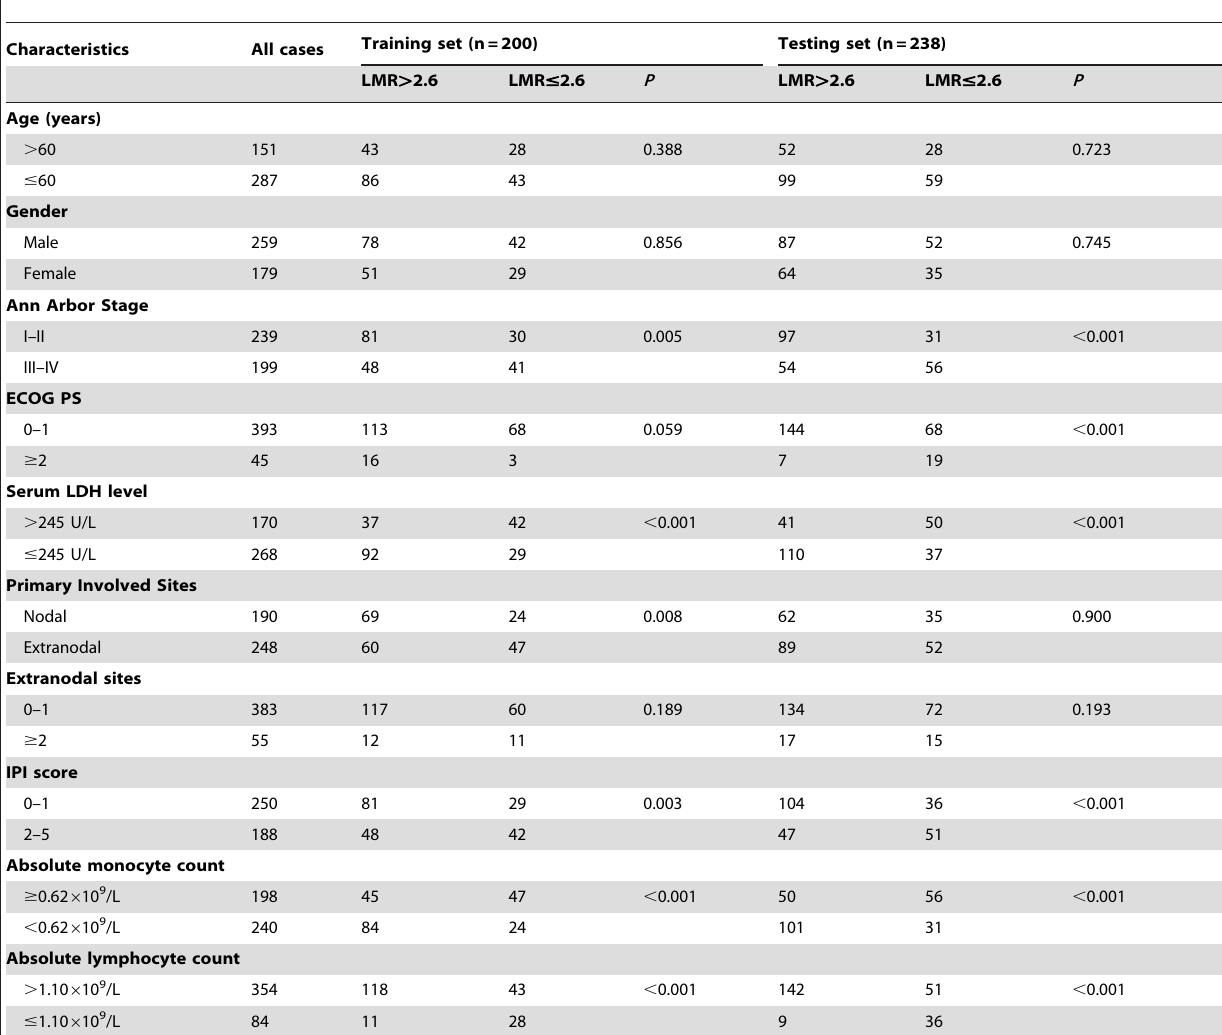
Table 1. Baseline clinical characteristics of patients with diffuse large B-cell lymphoma according to lymphocyte-to-monocyte